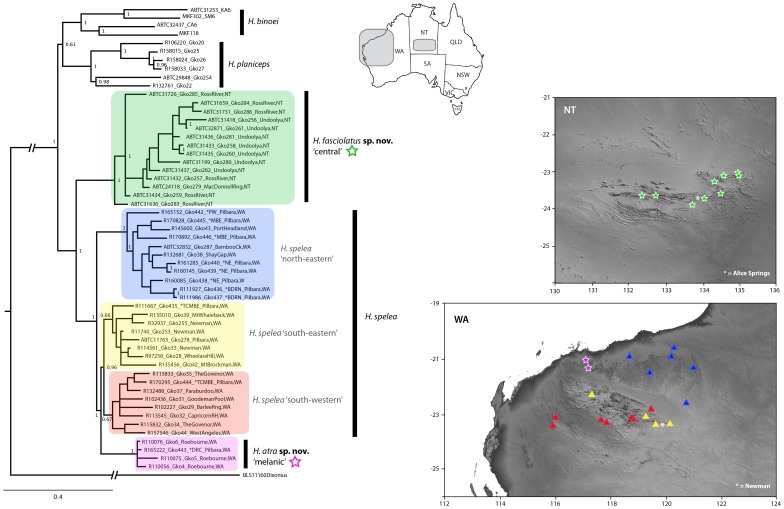
Genetic lineages of the H. spelea complex and their geographic distributions.Representative phylogram based on Bayesian analysis of nine nDNA loci of the Heteronotia spelea complex plus outgroups from Pepper et al. (2011). Values refer to Bayesian posterior probabilities. The outline of Australia shows the distribution of the Pilbara and central Australian lineages, while the insets show the detailed topography of these regions with sample localities colored to match the phylogeny. The distribution of H. fasciolatus
sp. nov. and H. atra
sp. nov. are indicated with green and pink stars, respectively.